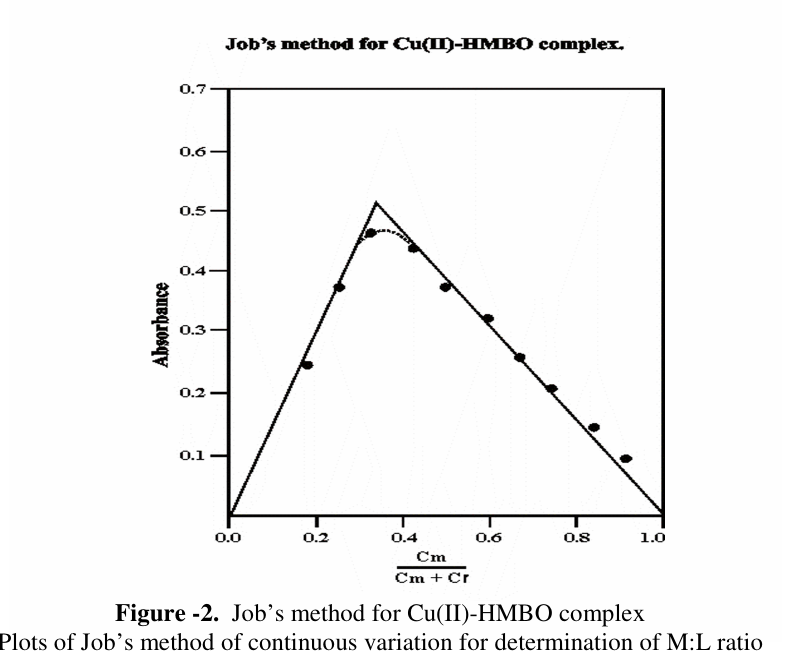
Figure -2. Job’s method for Cu(II)-HMBO complex Plots of Job’s method of continuous variation for determination of M:L ratio 0.005 M Cu(II), 0.005 M HMBO; pH = 5.0; (cid:3) = 400 nm.